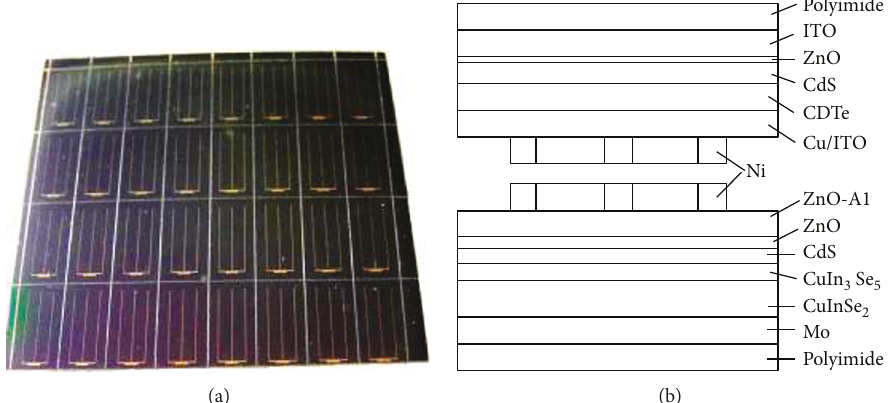
Figure 5: (a) Photo of a laboratory sample of the polyimide/ITO/CdS/CdTe/Cu/ITO SC. (b) The scheme of a tandem photoelectric converter CdTe/CuInSe 2